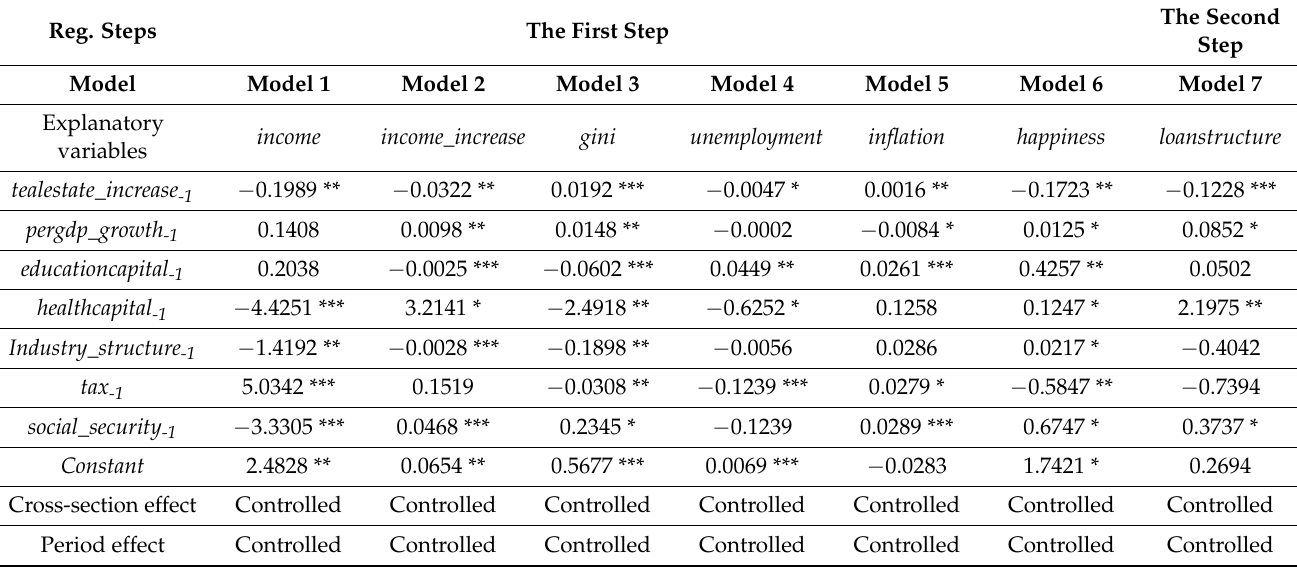
Table 5. Intermediary effect test results of real estate investment impact national happiness through loan preference (Steps 1 and